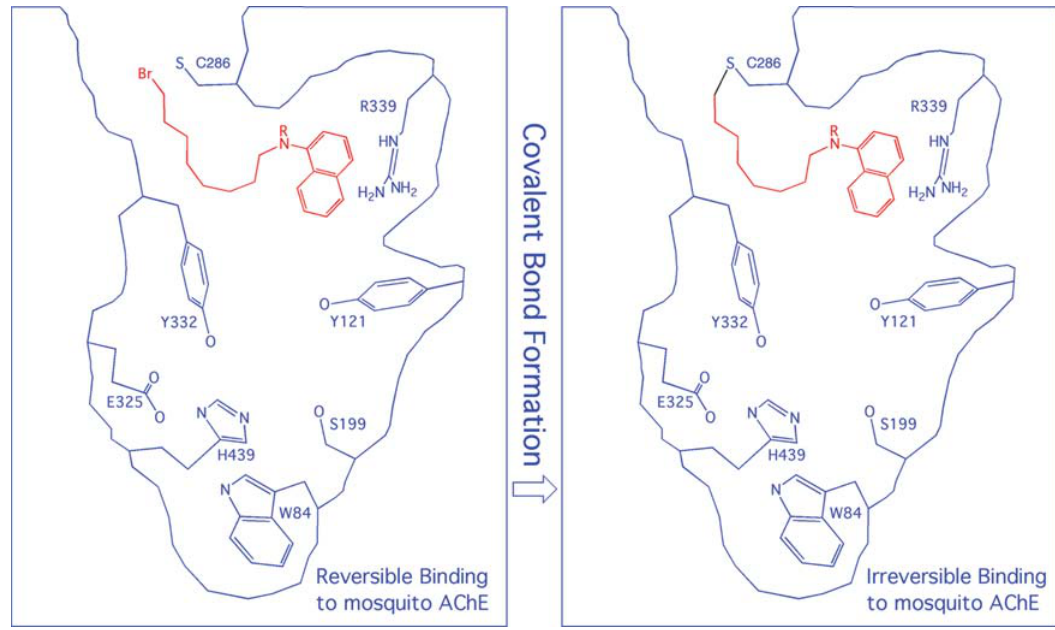
Figure 6. Cartoon representation of Anophelesgambiaeacetylcholinesterase bound with a suicide inhibitor.